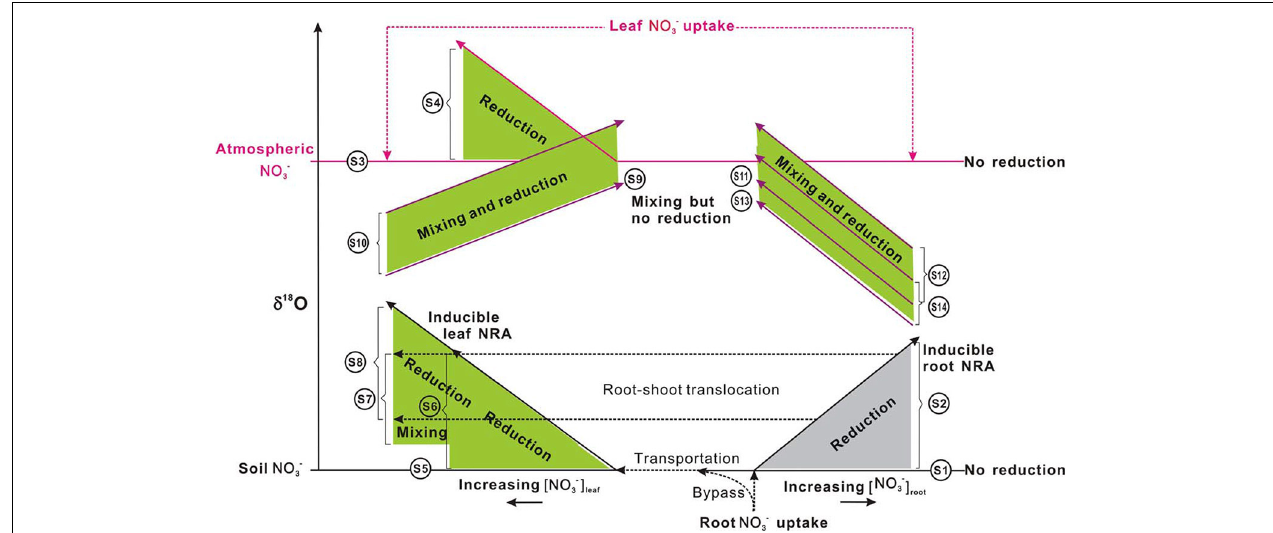
FIGURE 6 | Schematic showing δ 18 O-NO − 3 variations in plants under different uptake (from soil and or atmospheric sources: distinct in the δ 18 O value), translocation (from soil and or root to shoot), and reduction (potentially inducible by increasing [NO − 3 ] or no reduction and no isotopic enrichment with NO − 3 accumulation, depending on species). Long and short solid lines with arrows respectively show the vectors of − δ 18 O-NO − 3 and [NO 3 ] variations. Dashed lines with arrows show the uptake, transportation, and translocation of NO − 3 from the soil to roots and or to leaves, from atmosphere to leaves, during which isotope effects were regarded as negligible. Shaded areas (gray for roots, green for leaves) show isotopic enrichment during the mixing of different sources (the δ 18 O-NO − 3 in plants should be distributed between the δ 18 O values of sources, depending on the fraction of each source) and or the occurrence of NR reduction activities (the δ 18 O-NO − 3 in plants would be higher than the δ 18 O of sources but the magnitude of enrichment depends on in situ NR dynamics; presumably less than that presented in Table 1 ). For scenarios that occurred, leaf uptake of atmospheric NO − 3 was assumed to be homogeneous. The shaded area, the spatial distance, and length of lines had no quantitative implications. S1–S12 correspond to scenarios 1–12 in the main text.